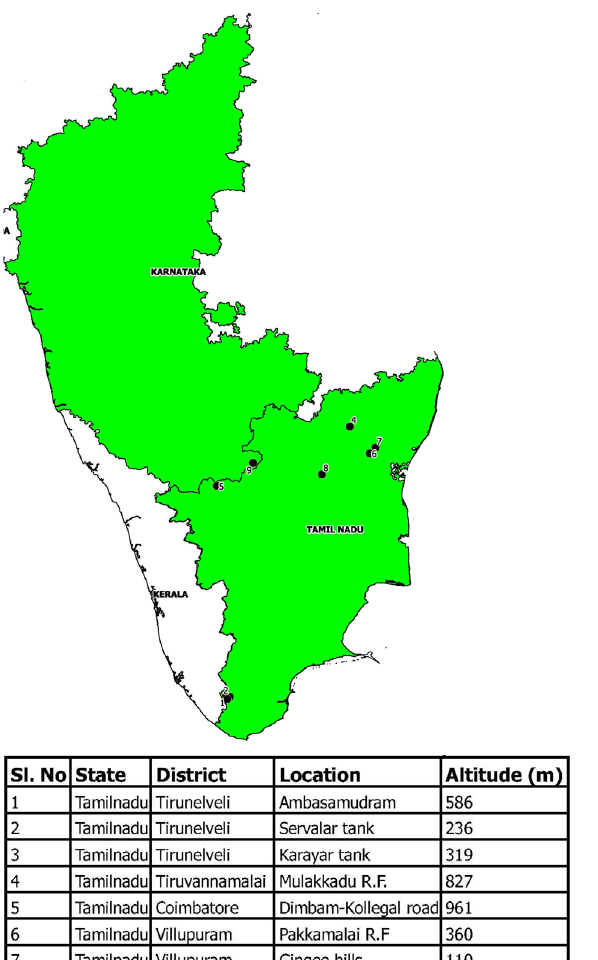
Figure. 1. Distribution of Diosypros